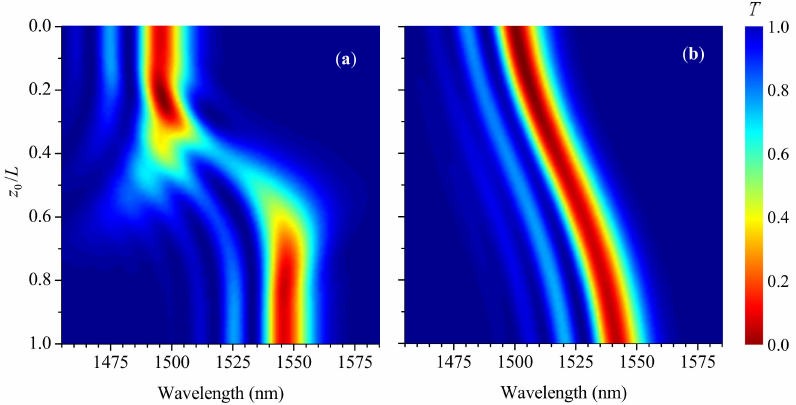
Figure 7. Evolution of transmission spectra for raised-cosine grating and two magnitudes of smooth- ness ( a ) η = 0and ( b ) 25 mm ( s 0 = 24